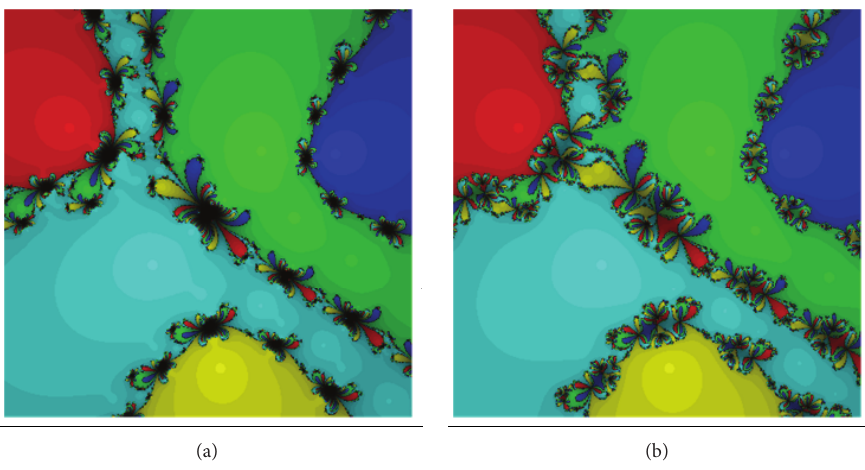
Figure 1: The methods (3) (a) and (5) (b) for Test Problem 1.